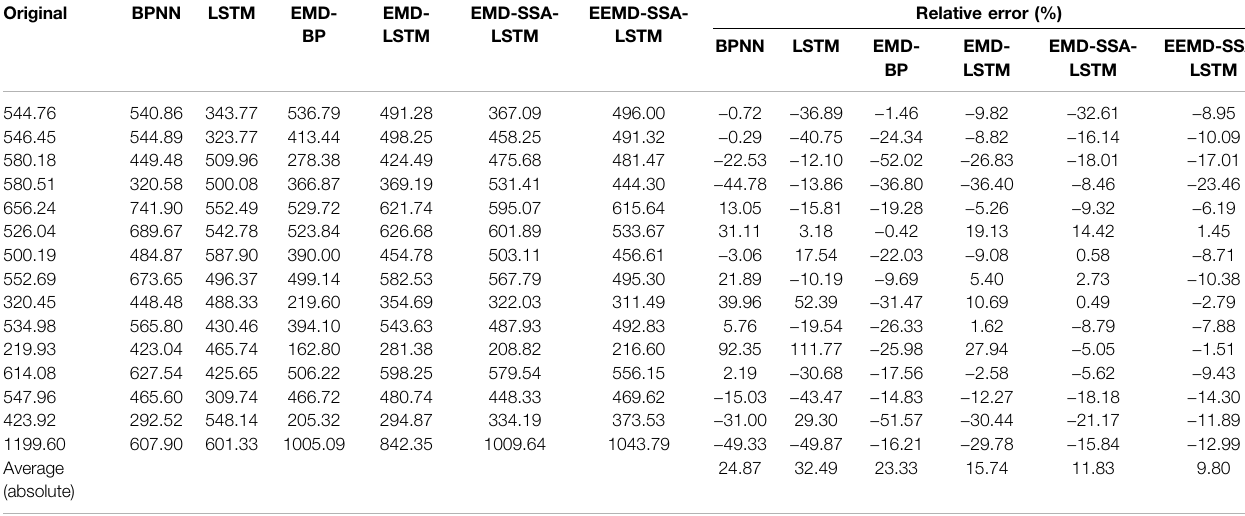
TABLE 5 | Peak fl ow estimates of different models for the Guangzhao Reservoir during the validation period. Original